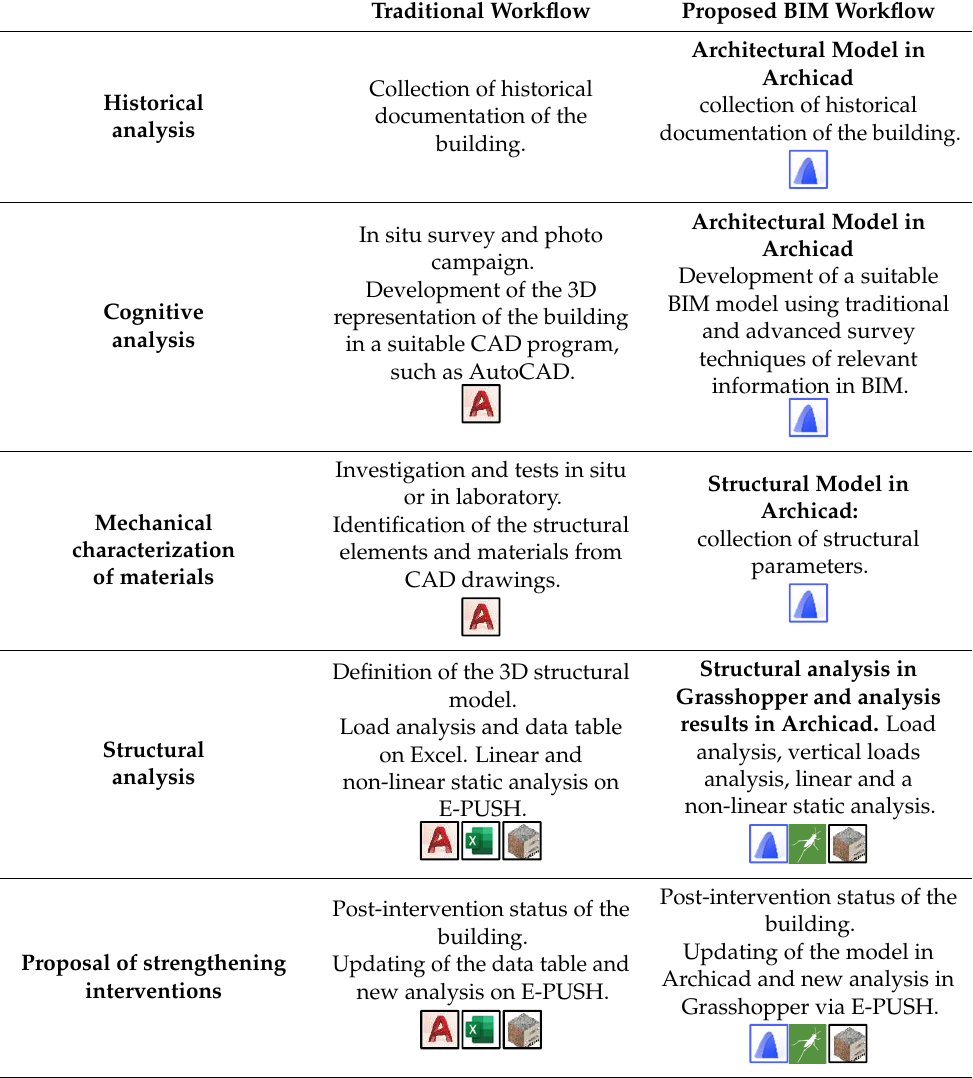
Table 1. Traditional workflow and proposed BIM workflow: procedure for the structural evaluation of existing masonry building.